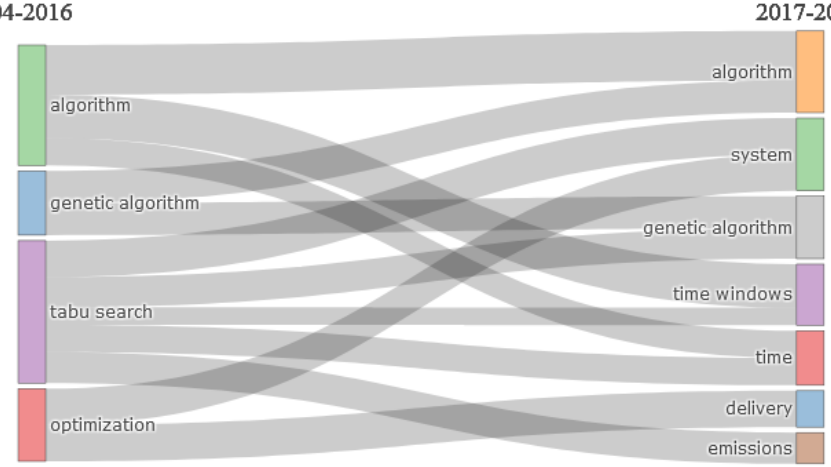
Figure 9. PSO/VRP Publication Thematic Evolution, measured by Web of Science Keywords Plus frequency.